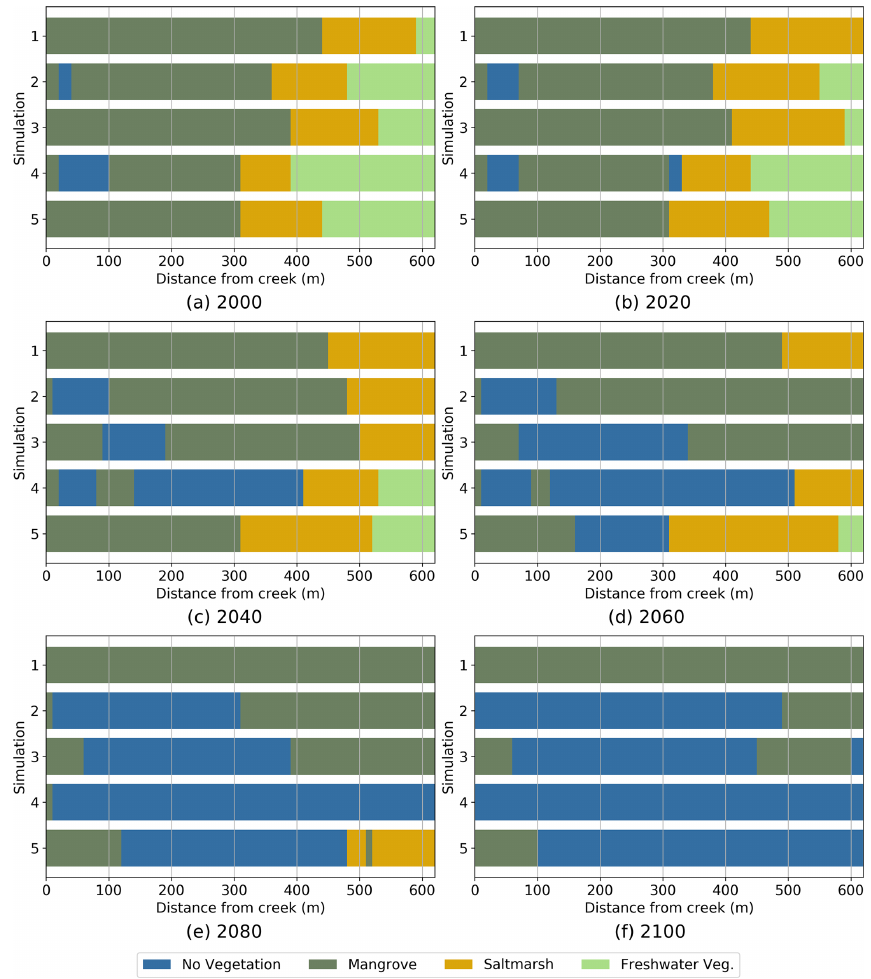
Figure 6. Predominant position occupied by each vegetation type in the tidal flat from 2000 to 2100. Simulations for high sediment input, SSC = 111gm − 3 . Simulations: 1 Bathtub, 2 Free tidal flat, 3 Inner channel, 4 Embankment with culvert and 5 Embankment and inner